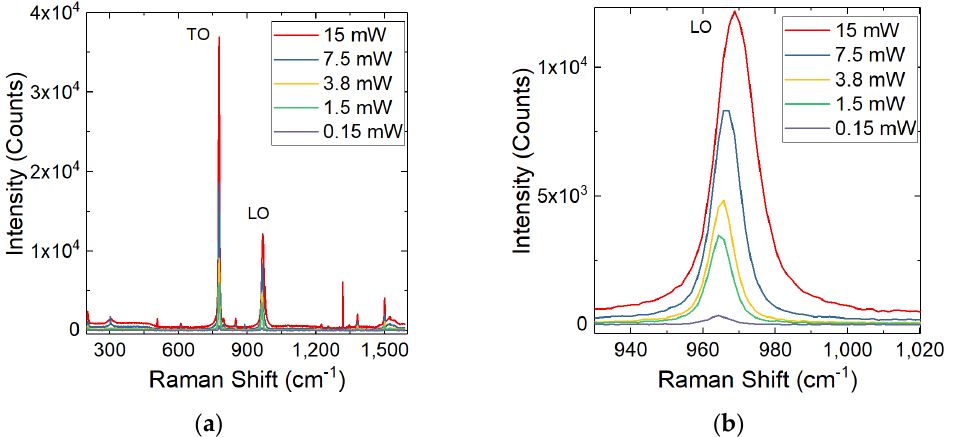
Figure 3. Raman spectra for 250 µm sample analyzed at different laser powers ( a ) and a focus on LO peak ( b ). The LO shift can be observed while TO peak is always in the same position.